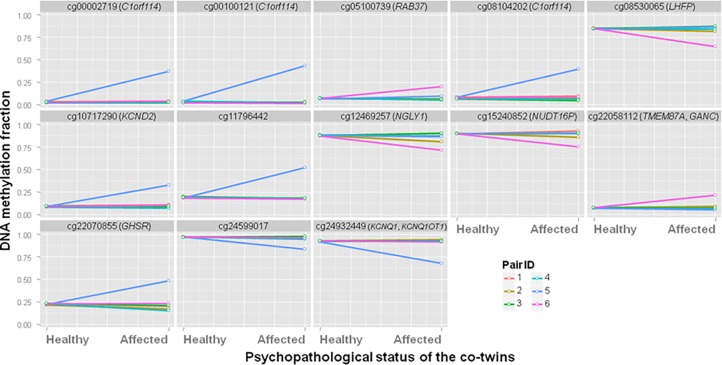
CpG probes with large and statistically significant DNA methylation variances in the diagnostic-discordant MZ twins.The thirteen probes displayed here are those with genome-wide statistically significant methylation variance increases in affected co-twins from the discordant pairs. PairID: randomly assigned pair number.